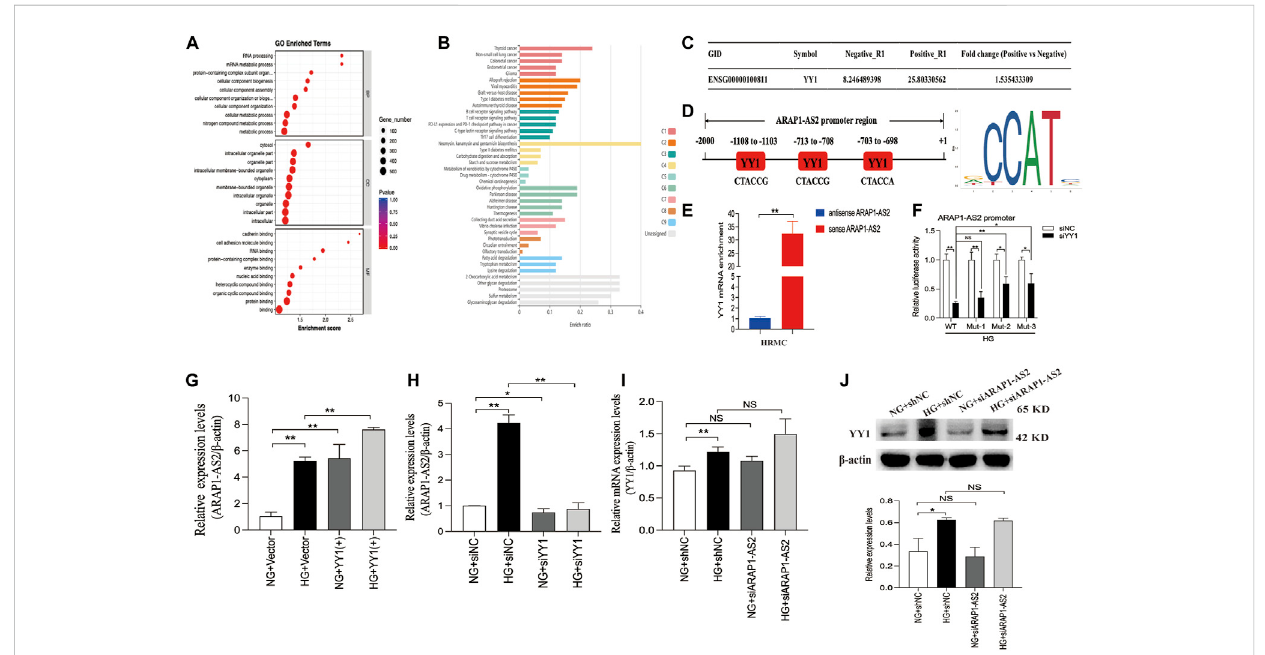
FIGURE 7 Regulatory mechanism of YY1 on ARAP1-AS2 (A) GO analysis of RNA pull-down seq. (B) KEGG enrichment analysis of RNA pull-down seq. (C) The enrichmentofYY1inthecomplexespulleddownbyARAP1-AS2.Ahigherfoldchangevalueindicatesmoreenrichment. (D) ThreeYY1bindingsitesinthe promoterofARAP1-AS2werepredictedbytheJASPARtool. (E) RNApull-downassayswereperformedtoexaminewhetherARAP1-AS2couldbindYY1in HRMCs. YY1 was pulled down by ARAP1-AS2, and the level of YY1 was measured by qRT-PCR. (F) Luciferase reporter analysis demonstrated the effect of YY1 silencing on the luciferase activity of the ARAP1-AS2 promoter reporter in indicated experimental groups. (G,H) Forty-eight hours after transfection of the YY1 overexpression plasmid or YY1 siRNA in the NG group and HG group, the expression level of ARAP1-AS2 was measured by qRT- PCR. (I) Forty-eighthoursafter transfection oftheARAP1-AS2siRNAin theNGgroup and HGgroup, themRNAexpression level ofYY1were measuredby qRT-PCR. (J) Forty-eight hours after transfection of the ARAP1-AS2 siRNA in the NG group and HG group, the protein expression level of YY1 was examined by Western blot analysis. In all panels, the data are representative of at least three independent experiments. Data are presented as the mean ± SD. * p < 0.05, ** p < 0.01, NS, not signi fi